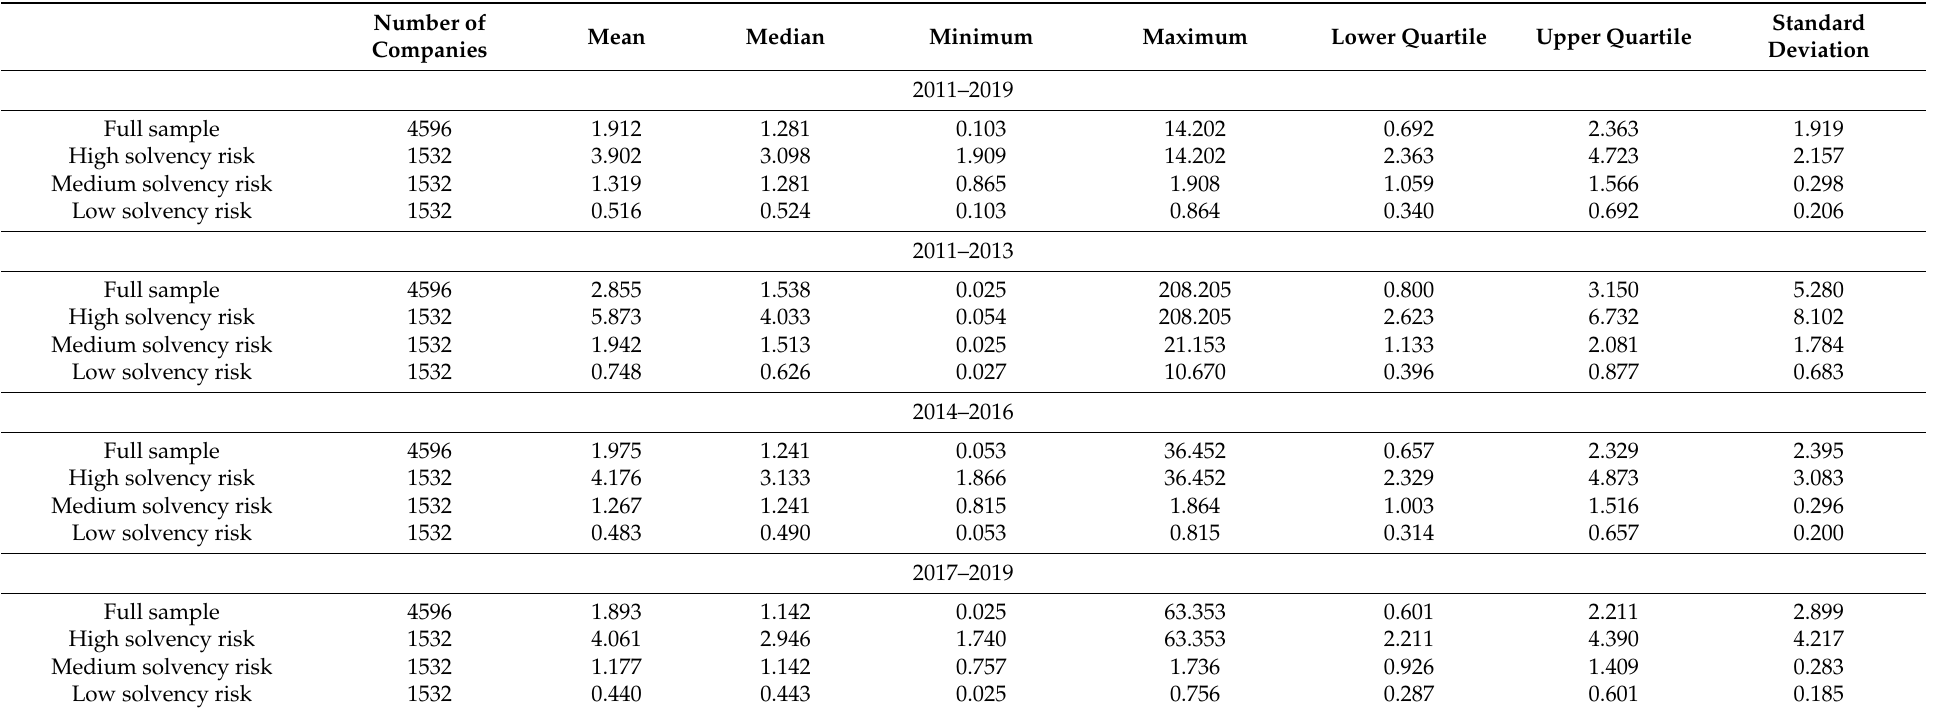
Table 2. Descriptive statistics of TD/SF, full sample, and categories,